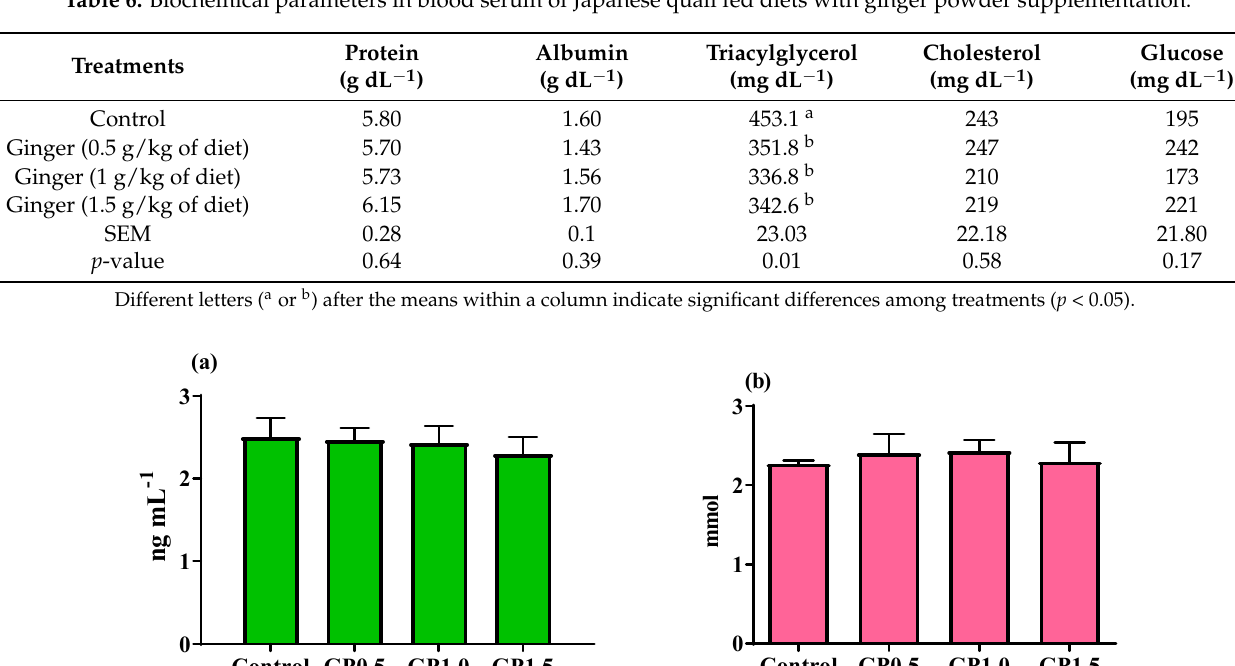
Control GP0.5 GP1.0 Figure 1. Concentrations of malondialdehyde (MDA) ( a ) and total antioxidant capacity (TAC) ( b ) in Japanese quails fed different levels of GP. Values (means ± SEM) within the same week with uncommon letters are significantly ( p < 0.05) different.